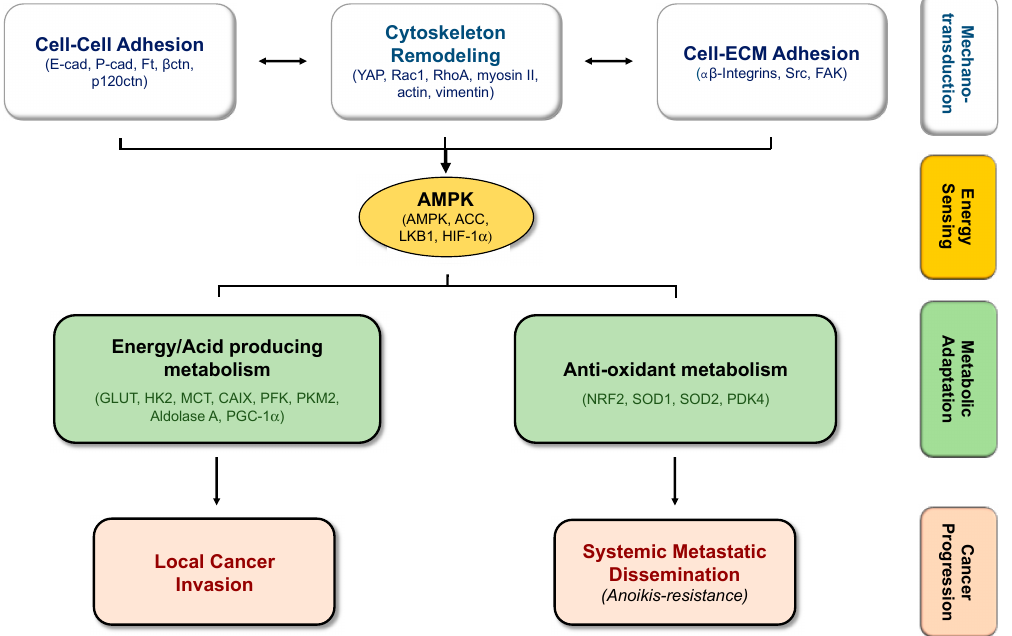
Figure 2. The molecular link between mechanotransduction and metabolic adaptations promotes cancer cell progression. Alterations in cell–cell and cell–ECM adhesion, leading to cytoskeleton remodeling, requires AMPK-induced ATP production through specific metabolic programs, supporting cancer progression.